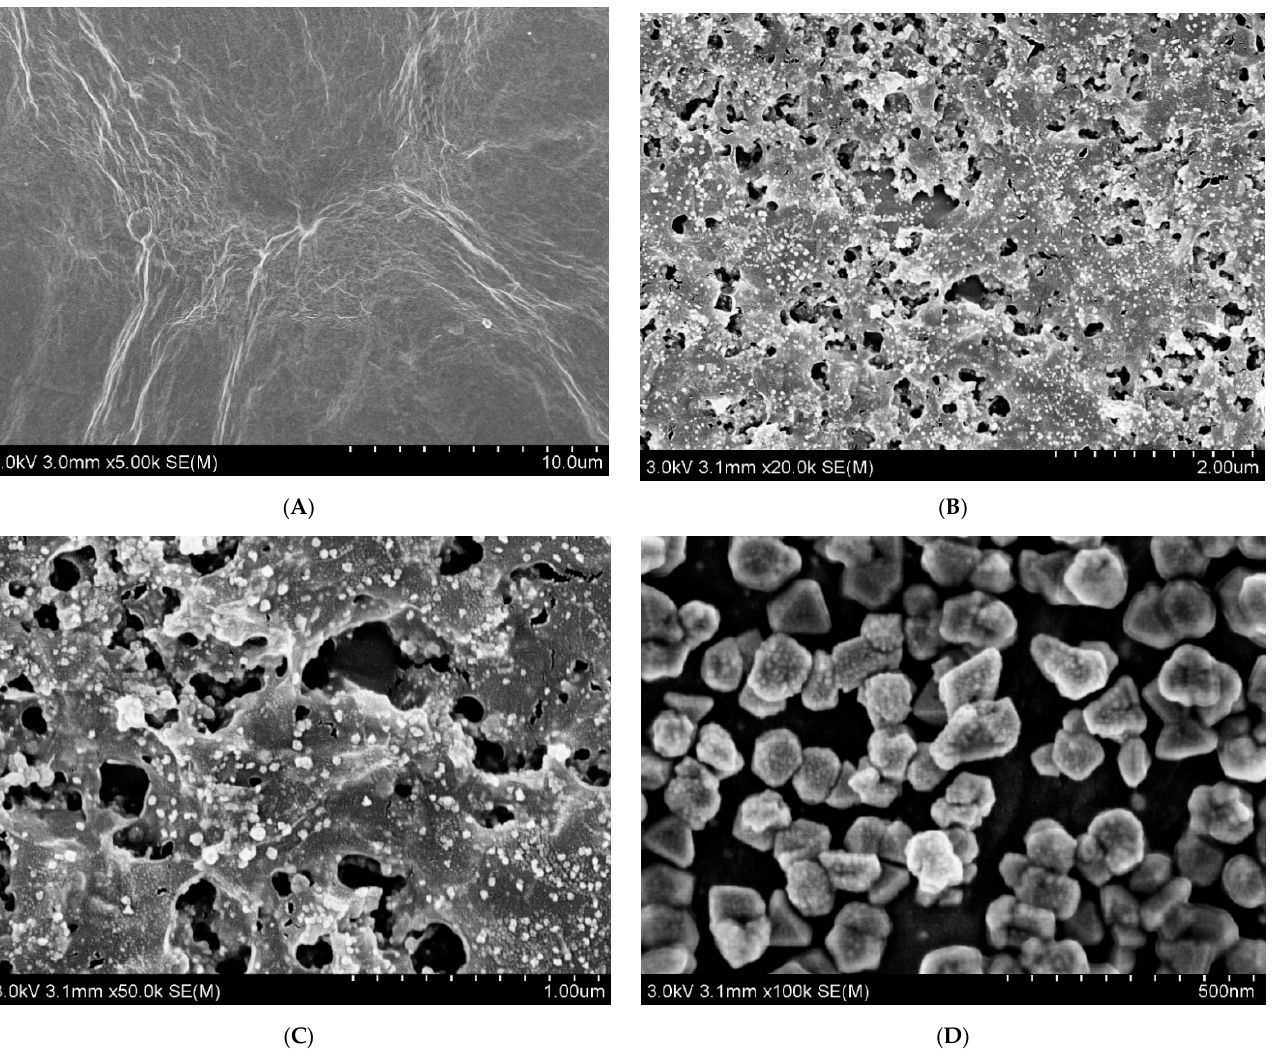
Figure 1. Scanning electron microscope (SEM) images of ERGO ( A ) and AuNPs/MXene/ERGO nanocomposite ( B – D ).